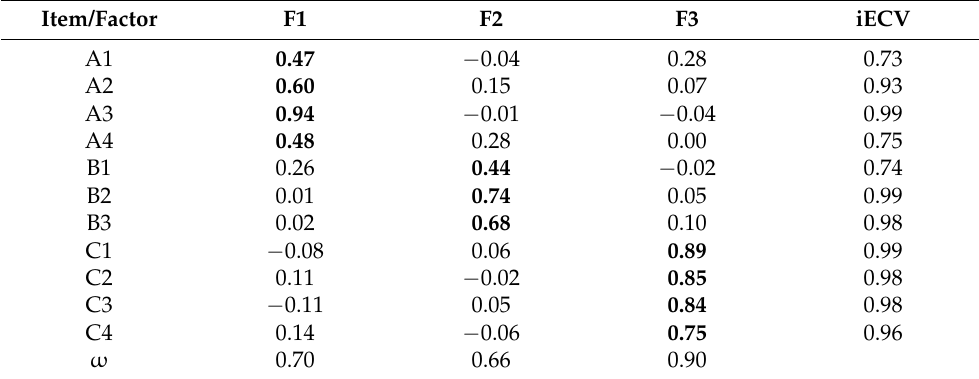
Table 3. Parameters of the ESEM (exploratory structural equation modeling) final